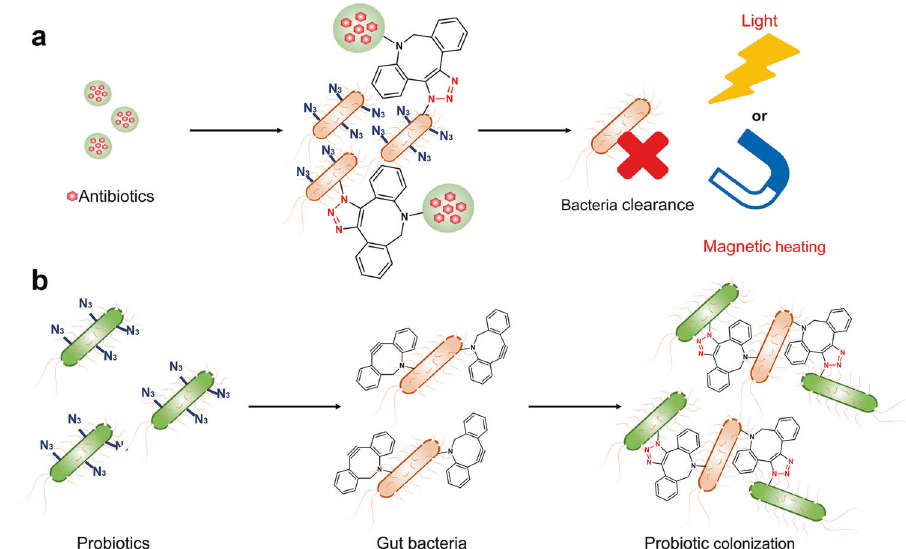
Fig. 5 Targeted delivery of antibiotics to bacteria. a Antibiotic nanoparticles bind to the N 3 -labeled bacteria by bioorthogonal chemistry and exert bacterial killing under the action of light or magnetic fi eld. b Improving probiotic colonization via bioorthogonal